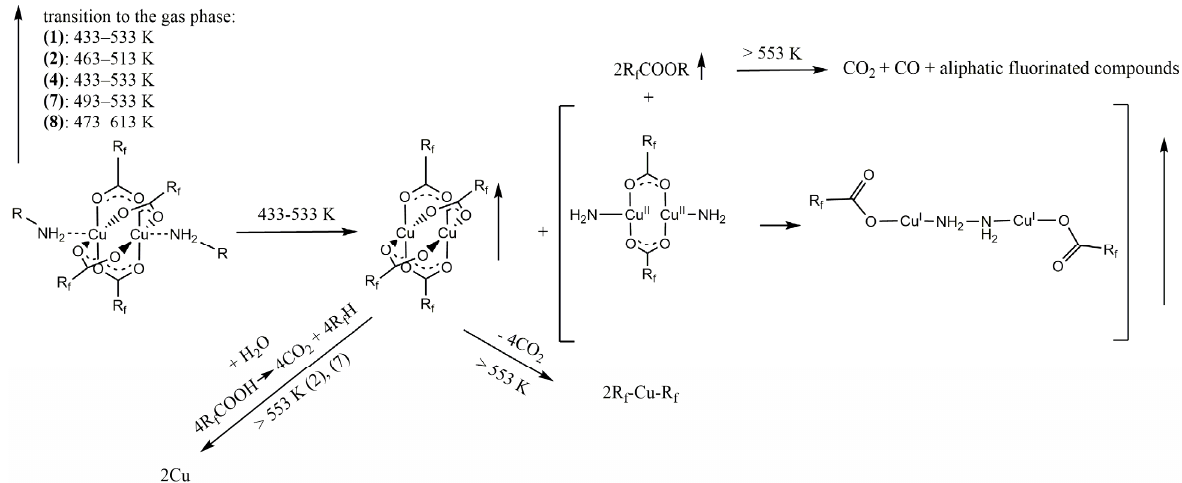
Figure 6. The thermal decomposition scheme for [Cu 2 (RNH 2 ) 2 ( µ -O 2 CR f ) 4 ] compounds ( 1, 2, 4, 7, and 8 ) based on VT IR results.